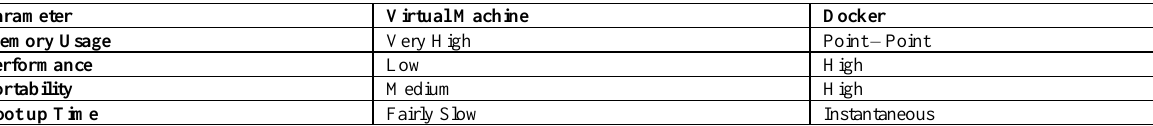
Table 2. Comparison between virtual machine and docker.